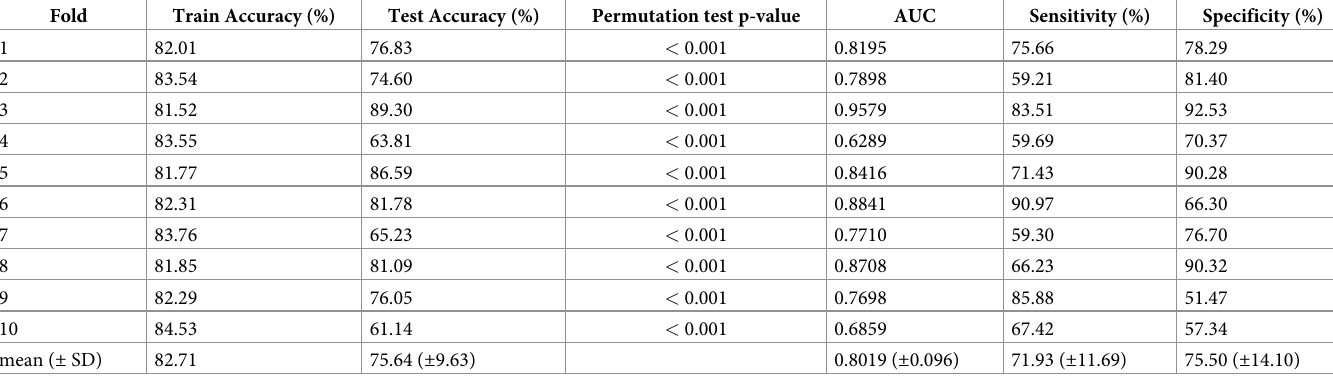
Table 4. The classification results of tenfold cross-validation with quadratic SVM classifier using 19 microstate features. Fold Train Accuracy (%) Test Accuracy